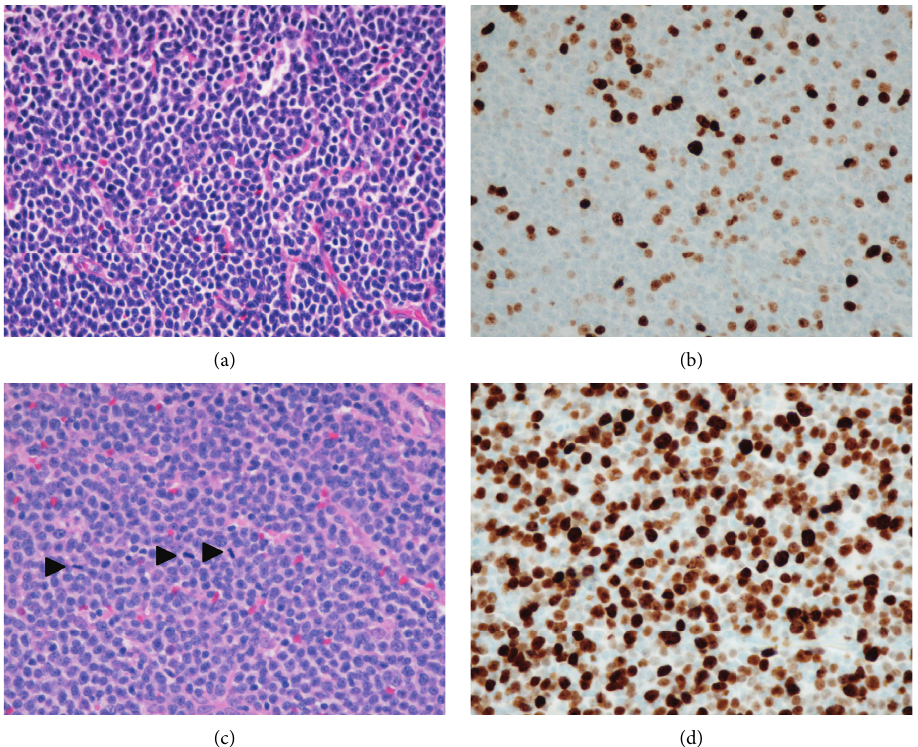
Figure 1: H&E sections of the lymph node excisional biopsy before transformation, demonstrating small round B-lymphocytes with clumped chromatin and rare mitosis (1a); Ki67 showing a low proliferation index (1b). 1c and 1d demonstrate increased cell size with numerous mitotic figures (arrowheads) and a significantly increased proliferation index by Ki67, respectively, at the time of early transformation. All images are taken at 400X